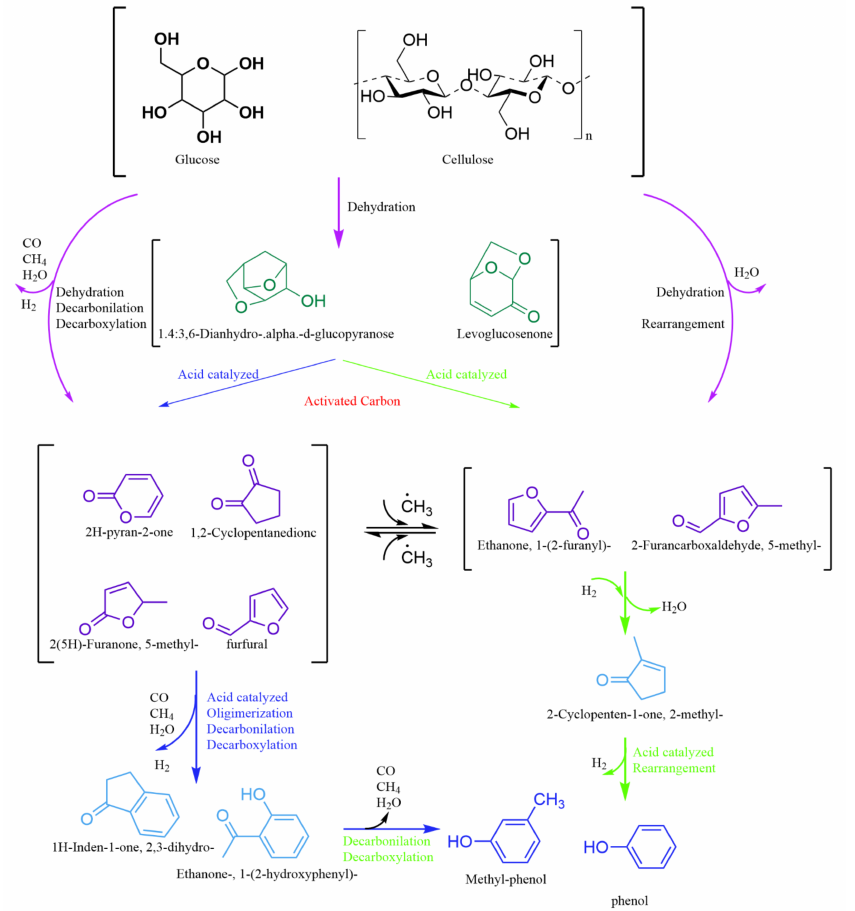
Figure 4. The proposed mechanism of forming phenols from catalytic pyrolysis of glucose and cellulose over AC catalyst